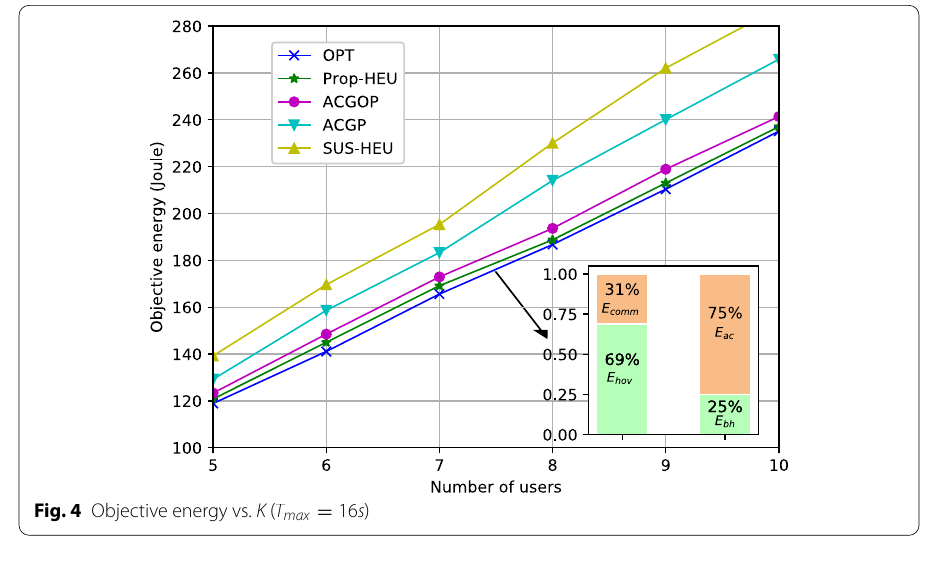
Fig. 4 Objective energy vs. K ( T max = 16 s )